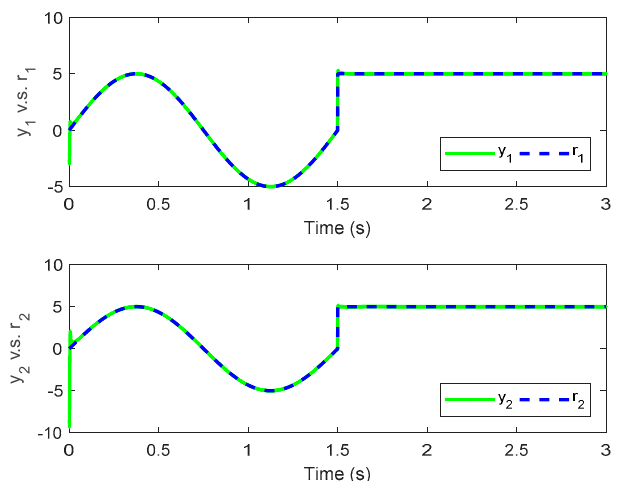
Figure 1. Flow chart for HTRDNA algorithm.